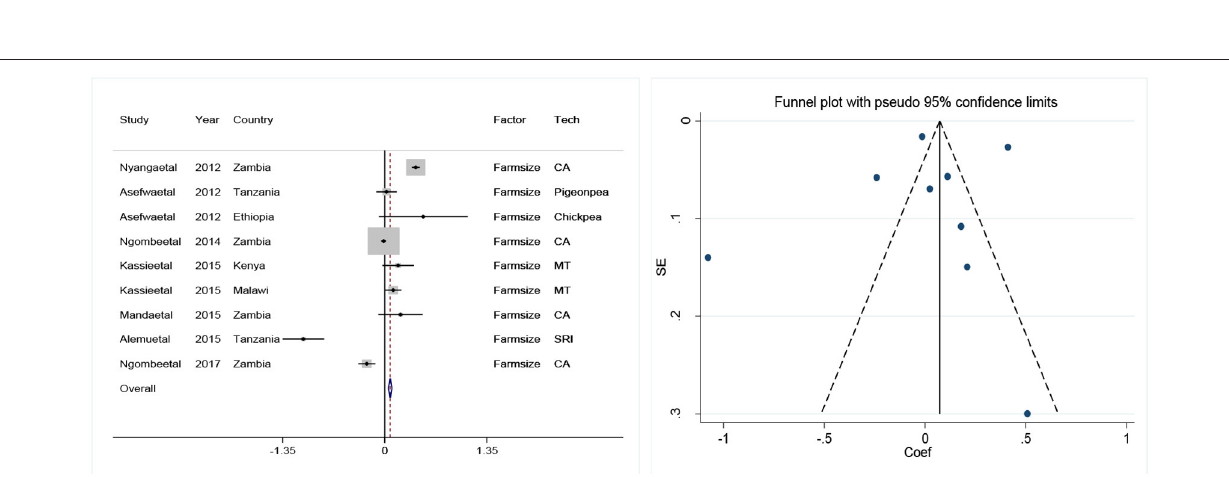
FIGURE 3 | The effects of farm size on the adoption of various CSA practices in parts of eastern and southern Africa. Source: Computed from Asfaw et al. (2012), Nyanga et al. (2012), Ngombe et al. (2014), Alem et al. (2015), Kassie et al. (2015), and Ng’ombe et al. (2017). The horizontal lines in the forest plots are the confidence intervals (CI) and the gray areas are study weights generated in the meta function. The dotted vertical line in the left panel shows the overall/combined effects. CIs that cross the zero line indicate statistical insignificance, while those on the left (right) show statistically significant negative (positive) effects. SRI denotes sustainable rice intensification and CA denotes the full set of minimum tillage, mulching and